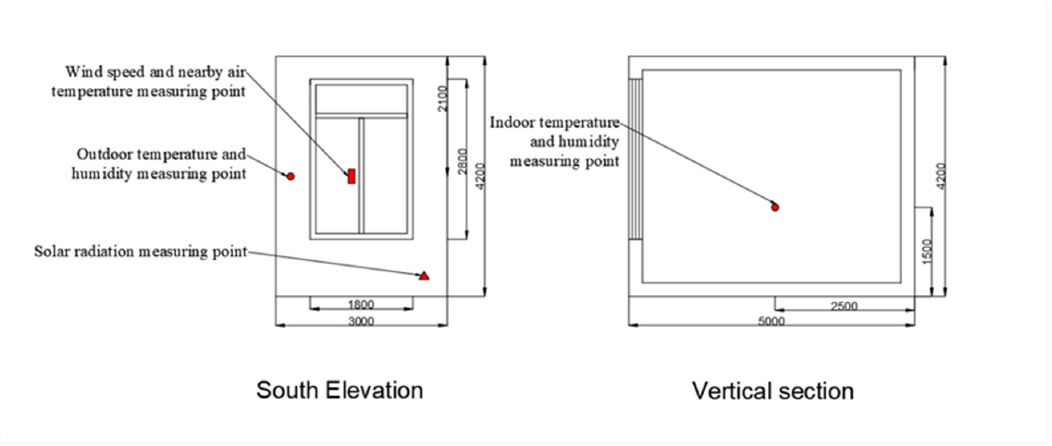
Figure 3. South elevation and vertical section of the measuring point layout.